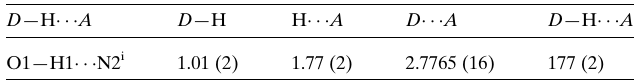
Table 1 Hydrogen-bond geometry (A˚ , (cid:2)